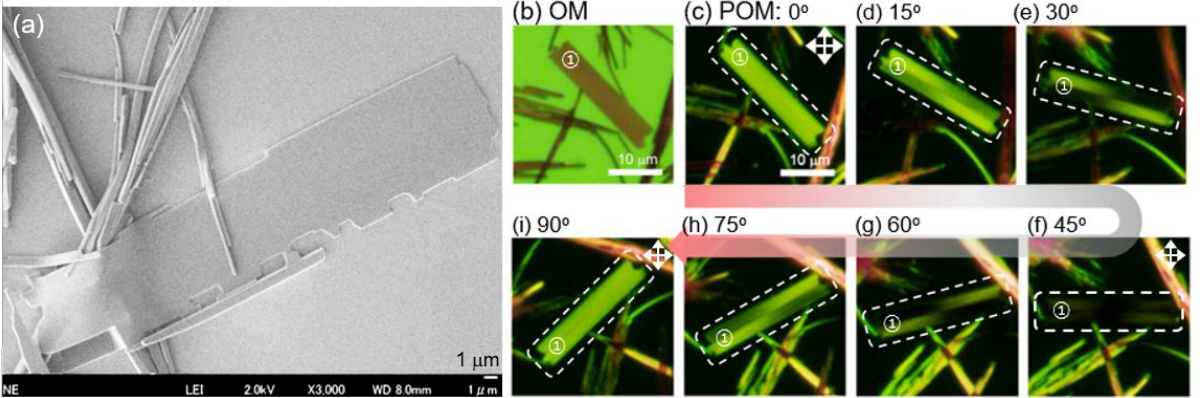
Figure 6. ( a ) SEM image of belts and sheets prepared from 25 µ M THF-H 2 O (1/1, v / v ) at 10–15 ◦ C. ( b ) OM and ( c – i ) POM images of birefringent microsheets placed between the crossed polarizers. The sample direction was rotated by 15 degrees with respect to the crossed polarizers.